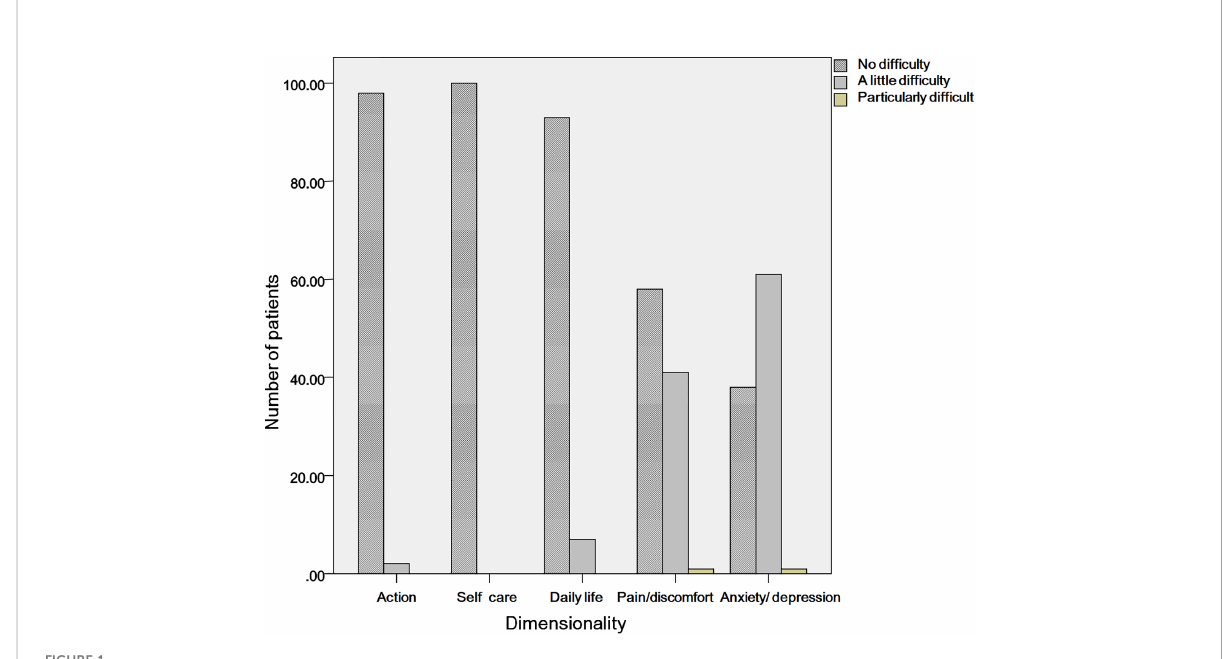
FIGURE 1 The distribution of the EQ-5D scores.